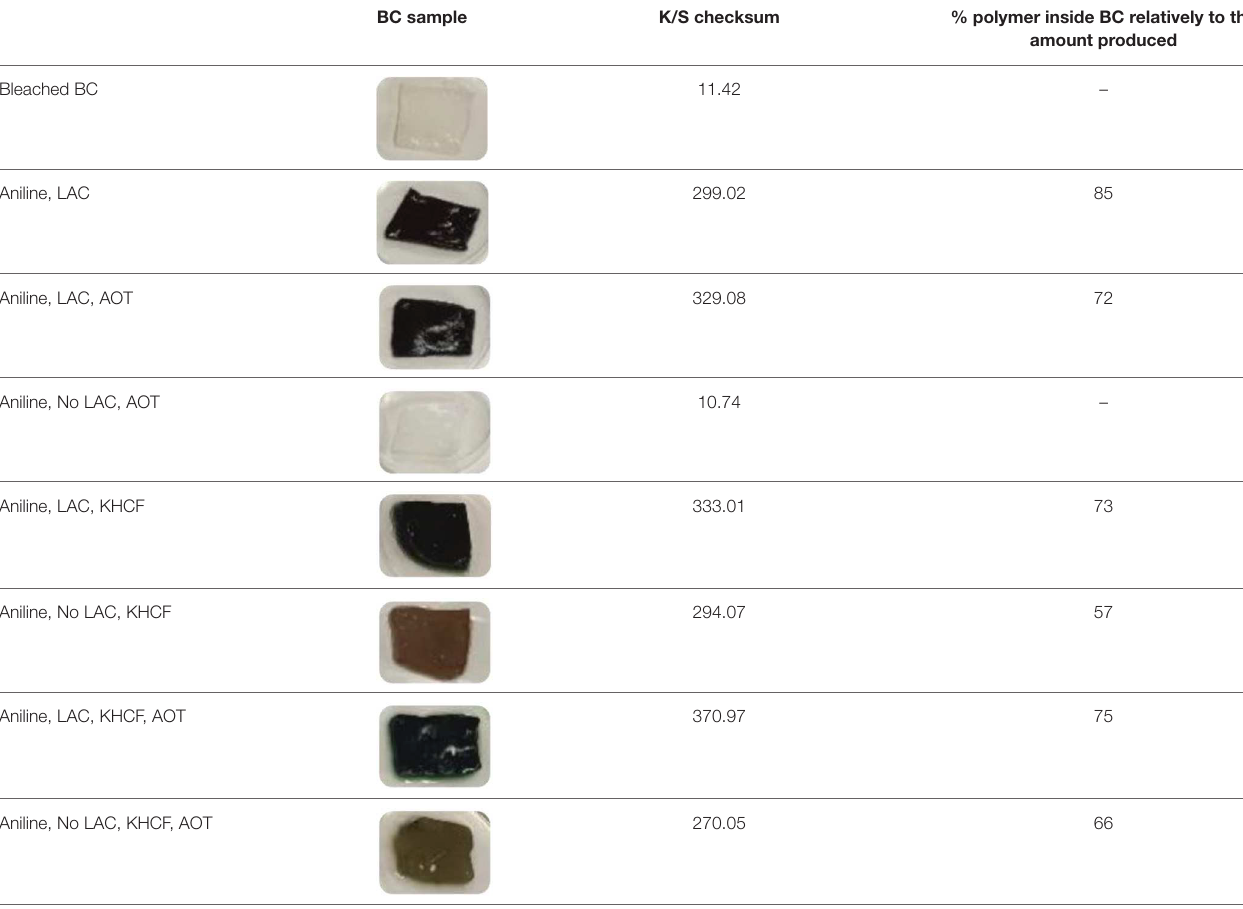
TABLE 3 | Photographs of BC samples; K/S checksum after polymerization under different conditions, and amount of polymer inside BC. BC sample K/S checksum % polymer inside BC relatively to the amount